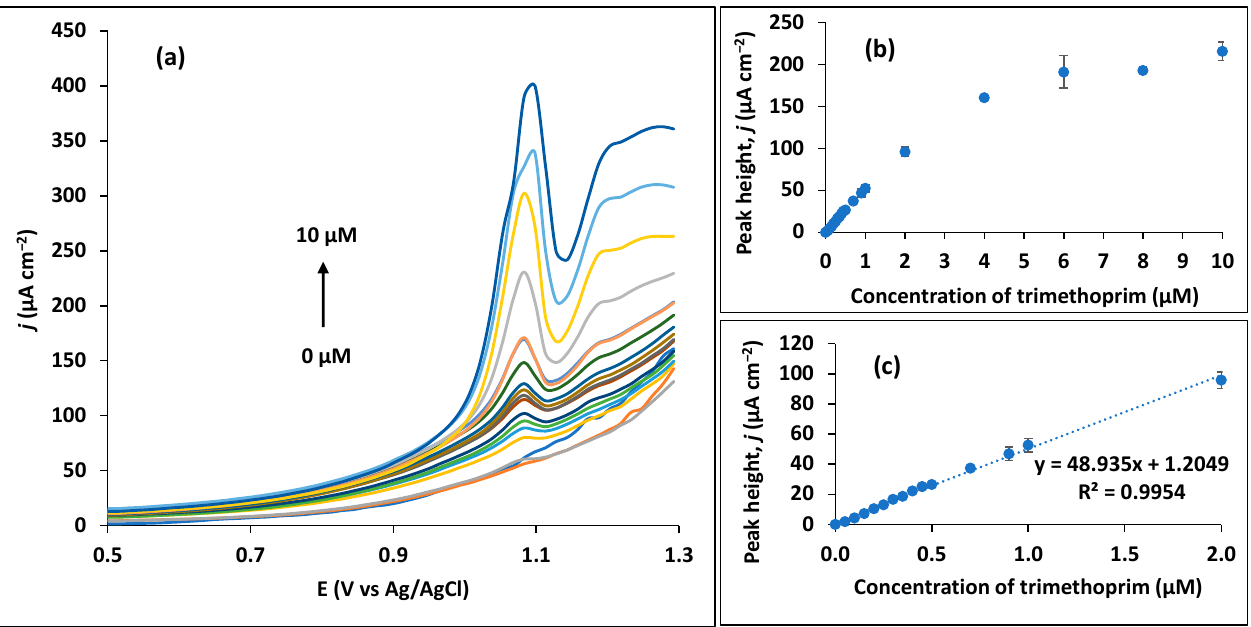
Figure 8. Assays for determination of the linearity range of trimethoprim in the optimum conditions (pH 7; SWV parameters: 0.02 V amplitude, 50 Hz frequency, and 0.015 V step potential; deposition of +0.7 V and deposition time of 60 s). ( a ) SWV curves up to 10 µM. ( b ) Peak height for all concentrations range tested (up to 10 µM). ( c ) Linear calibration range.